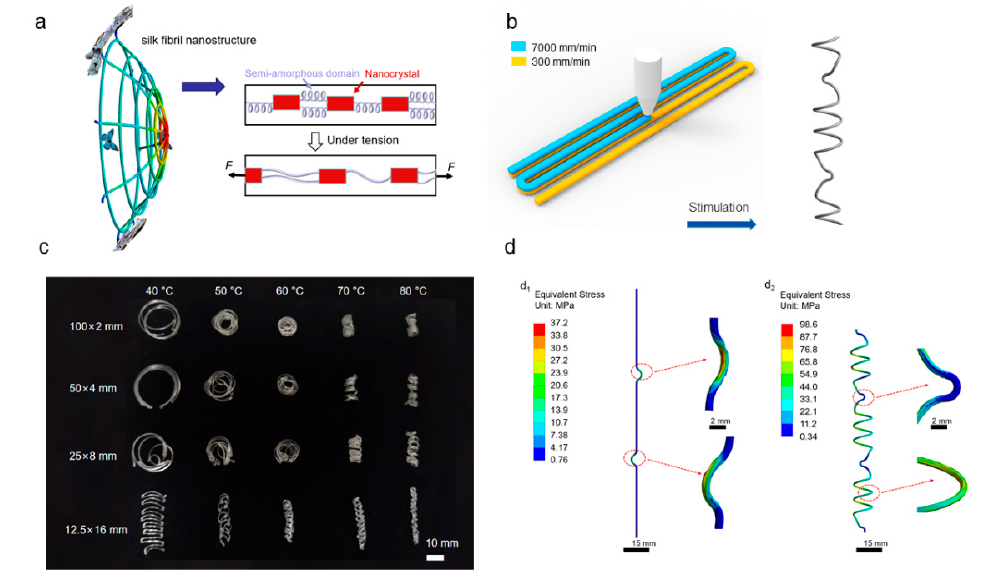
Figure 1. Schematic of bio-inspired spider webs catching prey when impacted ( a ); printing prin- ciple demonstration ( b ); bio-inspired spider silk is deformed with various nodes by